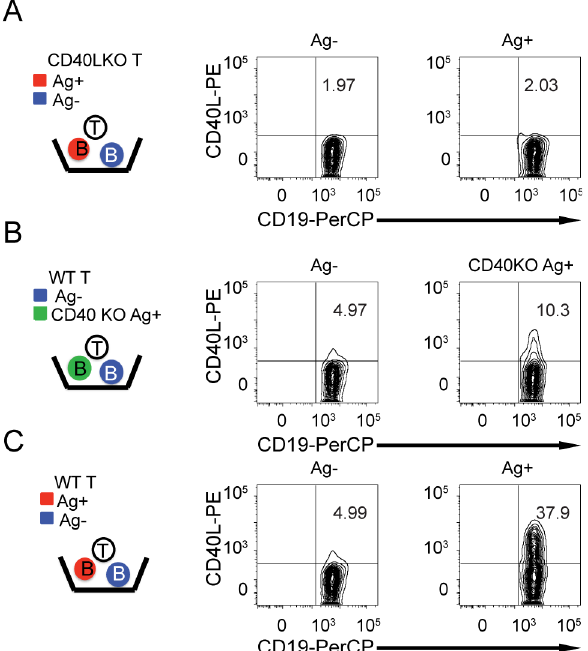
Fig 2. CD40L transfer by Th2 cells is antigen-specific and largely CD40 dependent. Antigen-pulsed B cells (Ag+, red) were mixed with unpulsed, bystanderB cells (Ag-, blue) and cultured overnight with Th2 cells in the presenceof 1 μ g/ml fluorescent anti-CD40L.( A ) CD40L knockout (CD40LKO) T cells do not transfer CD40Lto antigen-pulsed B cells or bystanders. ( B ) CD40L transfer by Th2 cells to CD40knock-out antigen- pulsedB cells (CD40KO Ag+) and CD40sufficient bystanderB cells. ( C ) CD40L transfer by Th2 cells to antigen-pulsed (Ag+) and bystander(Ag-) CD40sufficient B cells. This experiment is representative of 3 independent